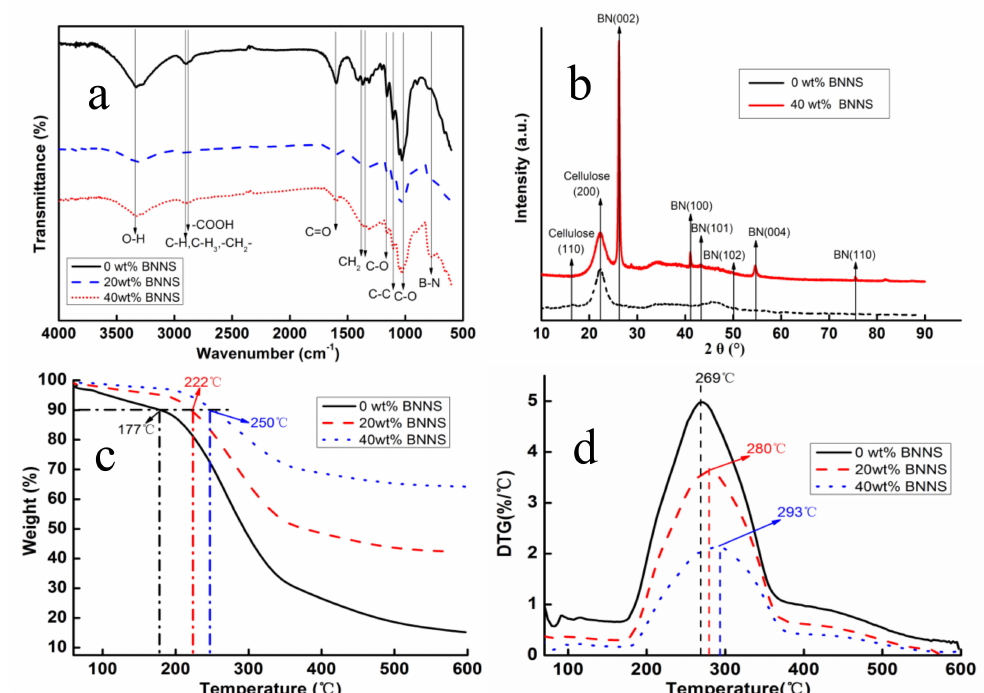
Figure 4. ( a ) FTIR spectra, ( b ) XRD patterns, ( c ) TG curves, ( d ) DTG curves of aerogel